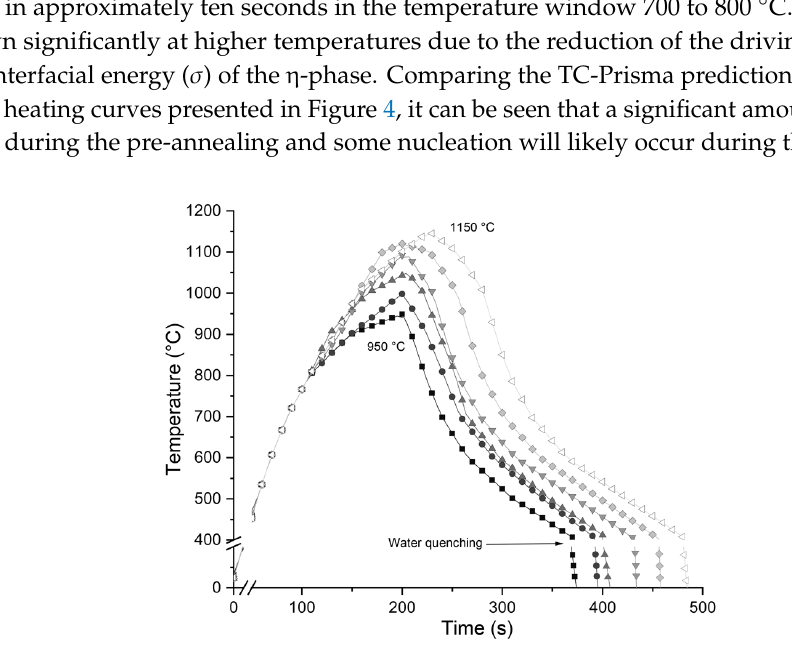
Figure 4. Thermal cycles of the Gleeble annealing simulations (peak temperatures 950–1150 °C).